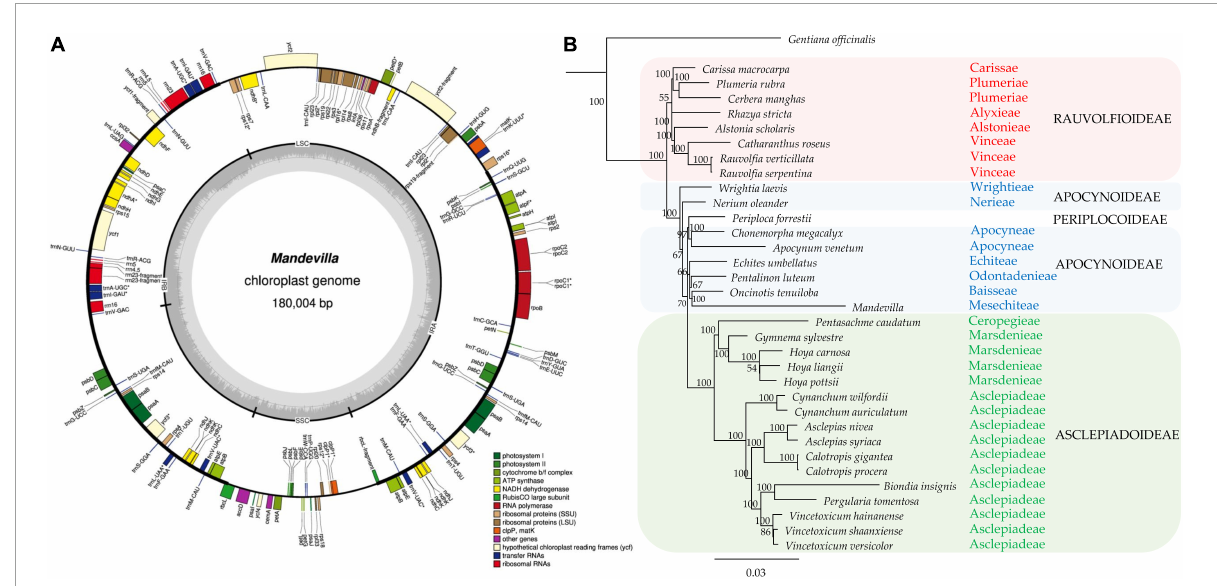
FIGURE2 (A) Annotation of the Mandevilla 2001 plastidial genome. Genes marked with an asterisk (*) contain introns. (B) The newly assembled Mandevilla plastome was aligned using MAFFT v7.450 under default parameters with 33 plastid genomes (from the Apocynaceae family) retrieved